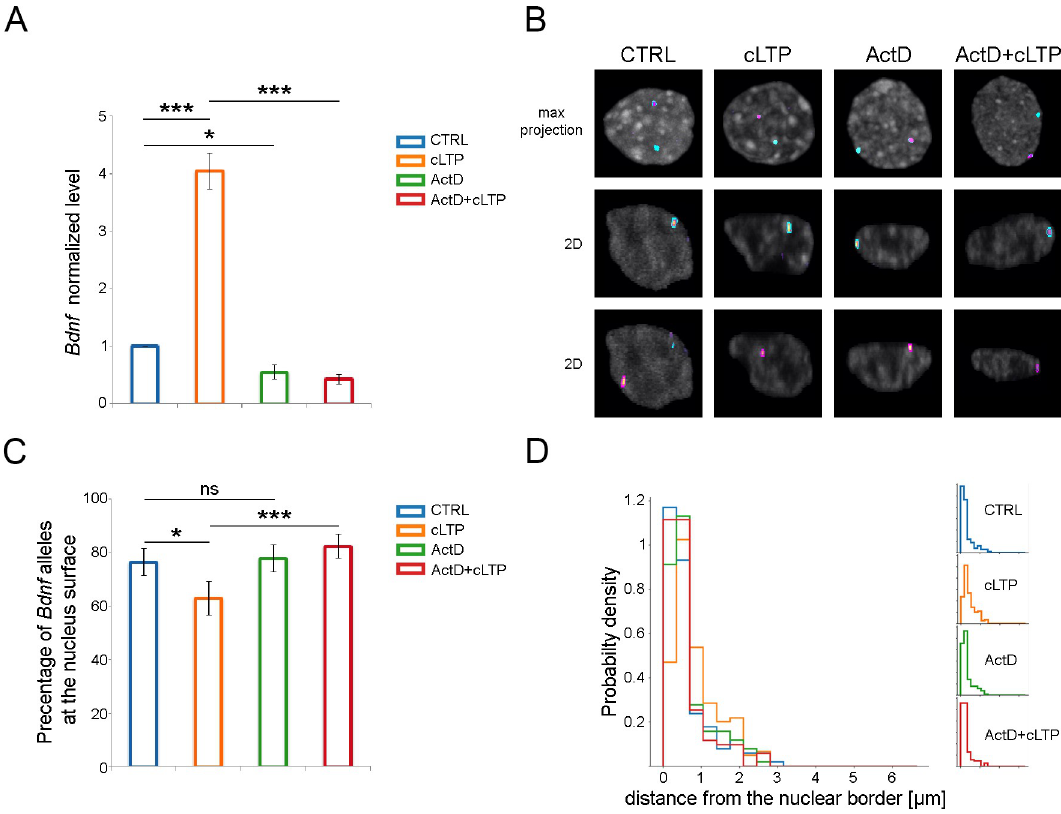
Fig 3. The causal relationship between Bdnf transcriptional activity and Bdnf’s allele repositioning. (A) The graph shows the expression of Bdnf normalized to control in the hippocampal neurons incubated for 2 hours with DMSO vehicle (CTRL, blue bar) or picrotoxin, forskolin, and rolipram (cLTP, orange bar), incubated for 2 hours with Actinomycin D and 2 hours with DMSO (ActD, green bar) or picrotoxin, forskolin, and rolipram (ActD+cLTP, red bar). Kruskal-Wallis group comparison: p < 0.01, and the One- Sample T-test or Welch Two Sample t-test for pairwise comparison: � p < 0.05, �� p < 0.01, ��� p < 0.001; error bars indicate standard error of the mean for 3 independent experiments (B) Representative picture of the nuclei of hippocampal neurons treated as described above. Hoechst 3342 staining for chromatin is shown in greyscale and segmentation of FISH signals for the Bdnf gene are shown in magenta and cyan. (C) Percentages of Bdnf alleles localized < 350 nm to the nuclear surface are shown (Chi-square test, all groups, p < 0.001; Fisher’s exact tests � p < 0.05, ��� p < 0.001, error bars indicate standard deviation of the binomial distribution). (D) Quantitative analysis of the intracellular positions of Bdnf alleles in the nuclei of hippocampal neurons treated and color-coded as in A. The minimal distance between the respective alleles and nucleus surface is presented in the normalized